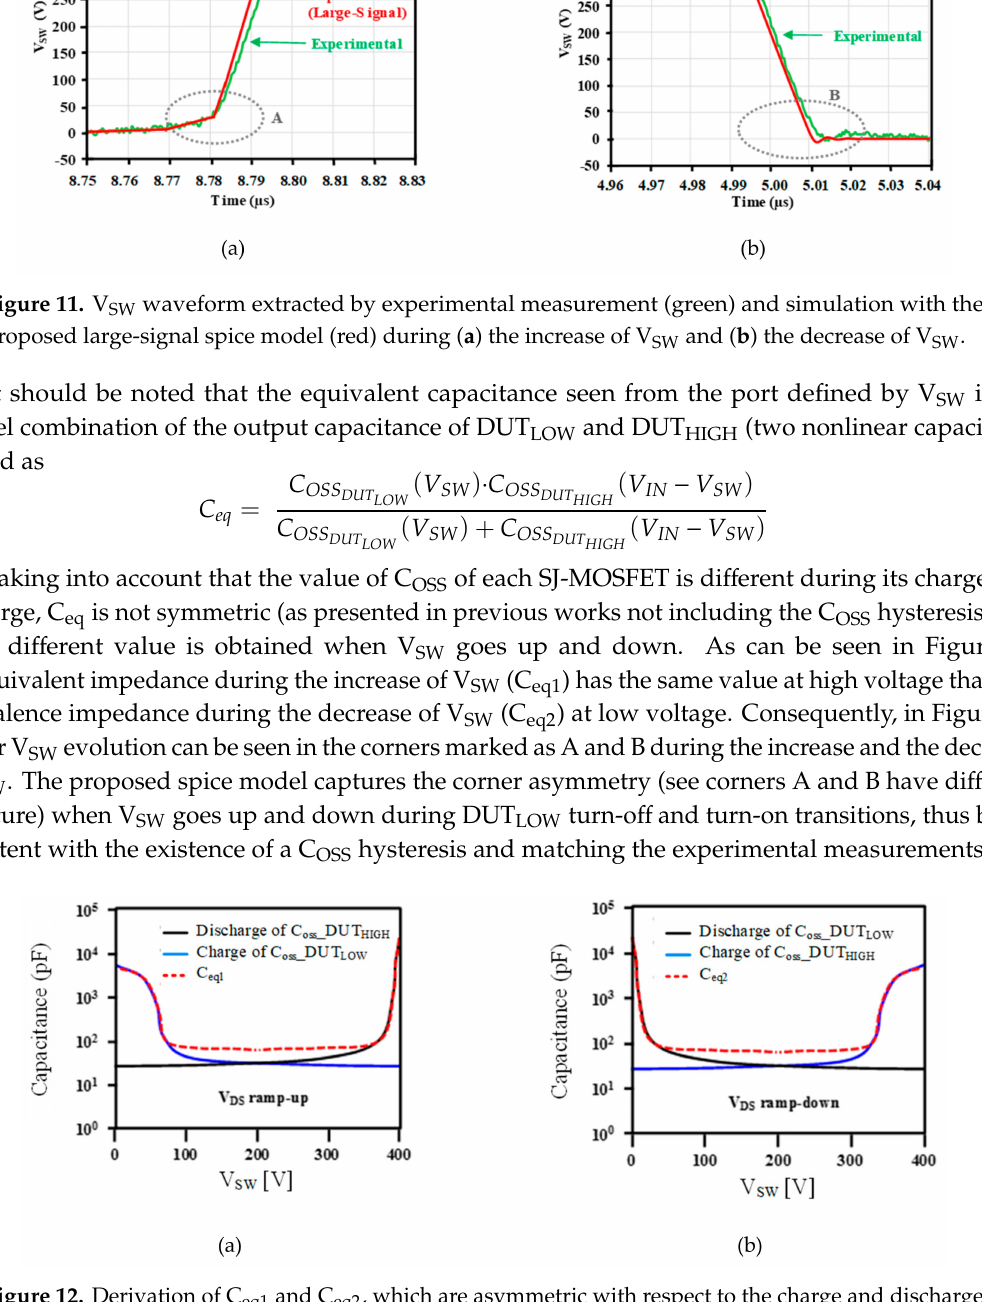
Figure 12. Derivation of C eq1 and C eq2 , which are asymmetric with respect to the charge and discharge of the C OSS of DUT HIGH and DUT LOW . ( a ) Increase of V SW and ( b ) decrease of V SW